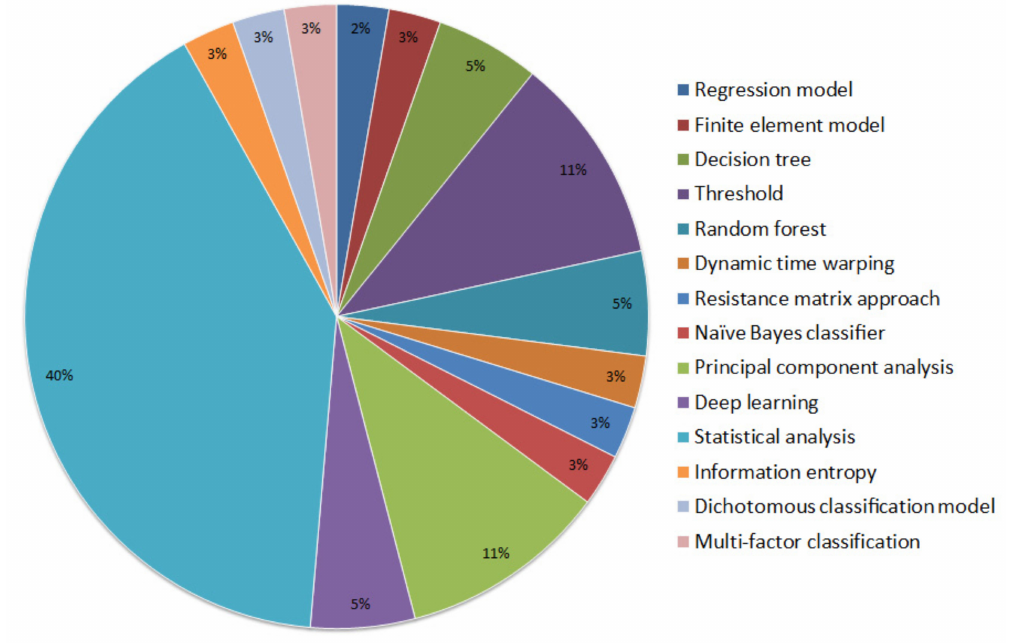
Figure 3. Summary of methods used to classify sitting postures which are believed to be associated with subjective